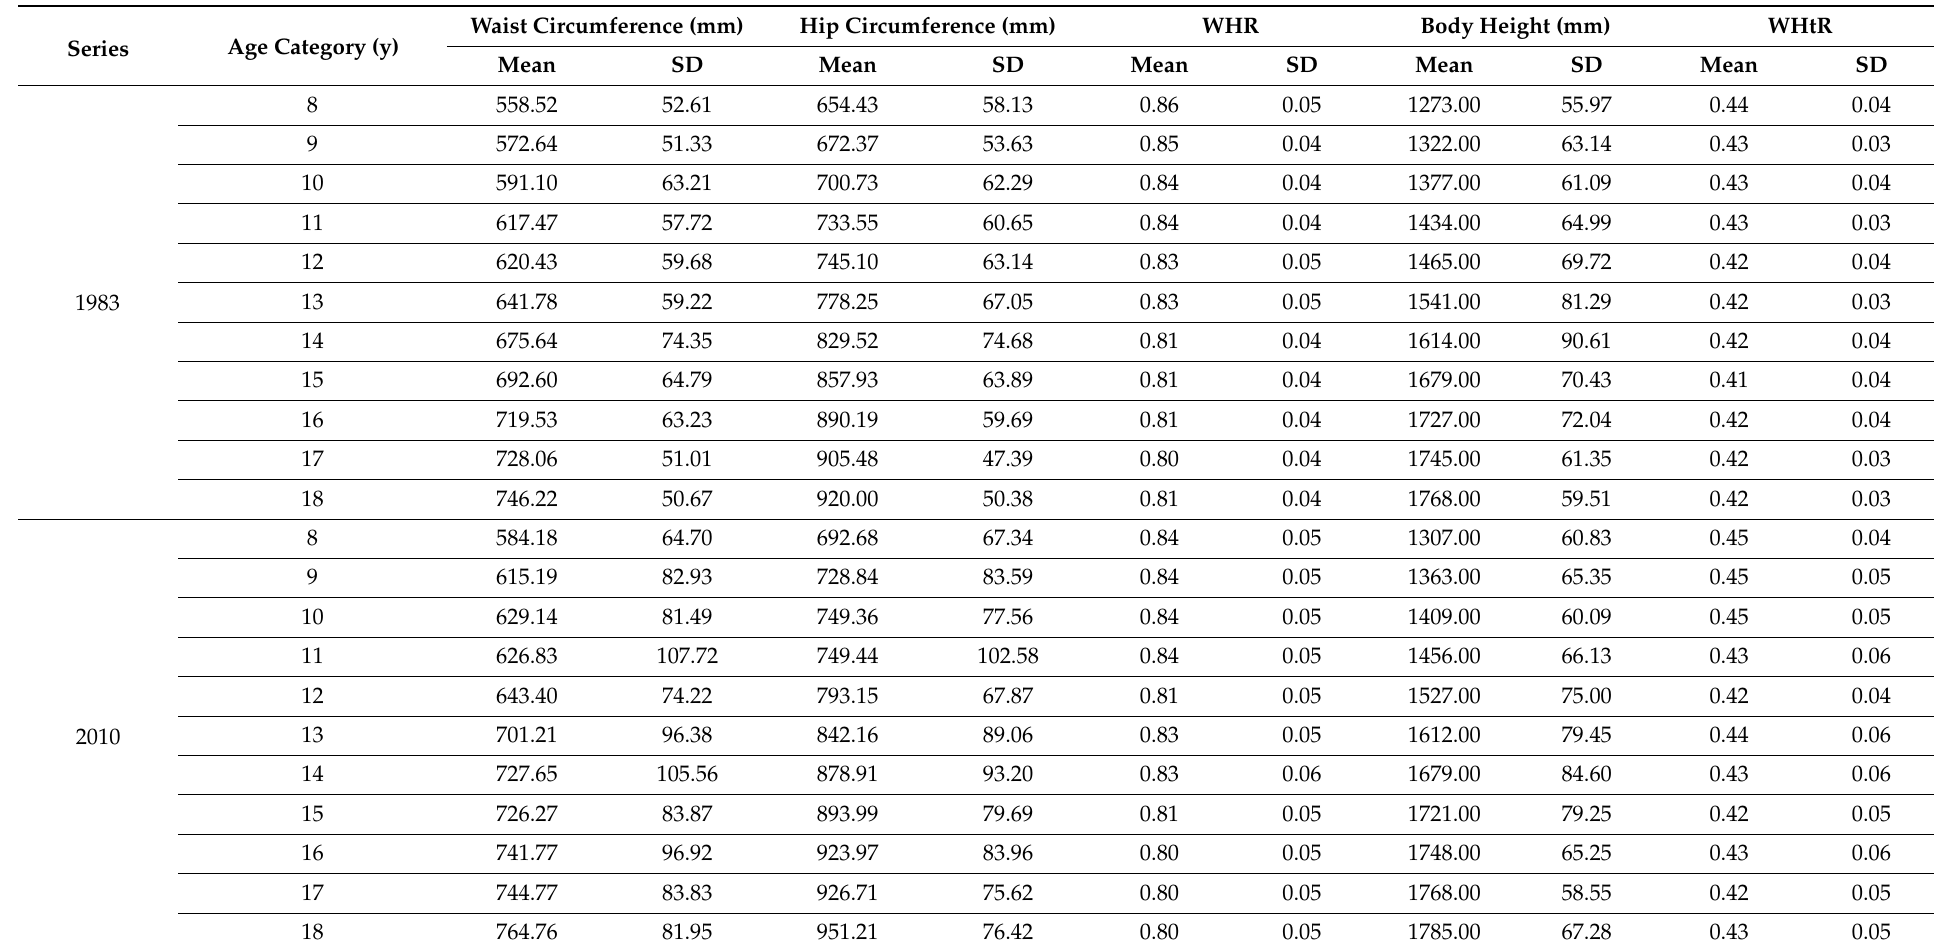
Table 4. Descriptive statistics for boys—means and standard deviations (SDs) for the analyzed